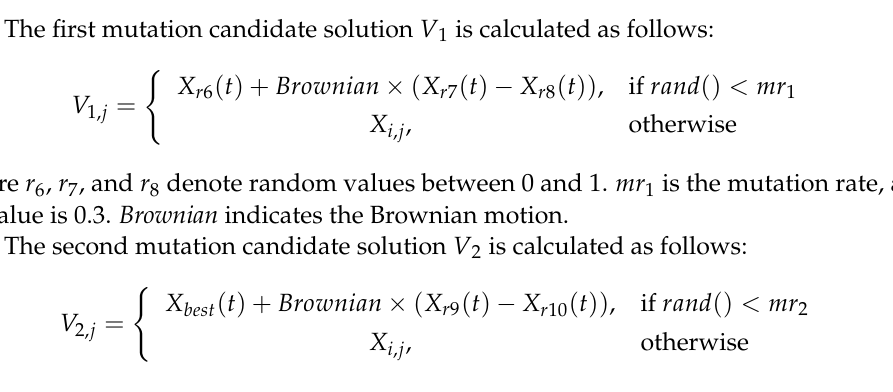
Figure 4. Brownian distribution and 2D Brownian trajectory.